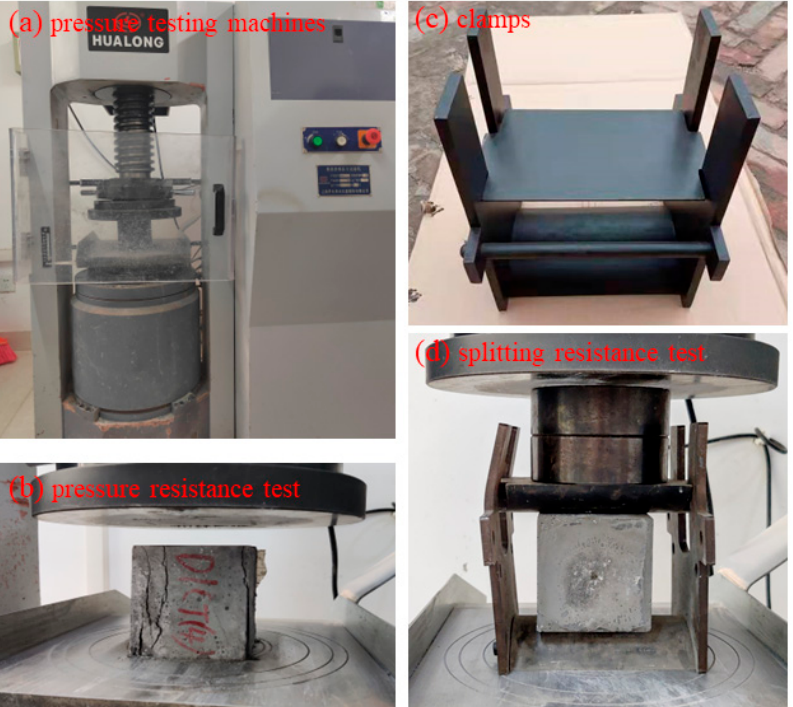
Figure 3. The compressive and splitting strength tests. ( a ) the loading mold of uniaxial compression; ( b ) the loading procedures of compressive strength test; ( c ) the pad clamp for splitting strength test; ( d ) the loading procedures of splitting strength test.